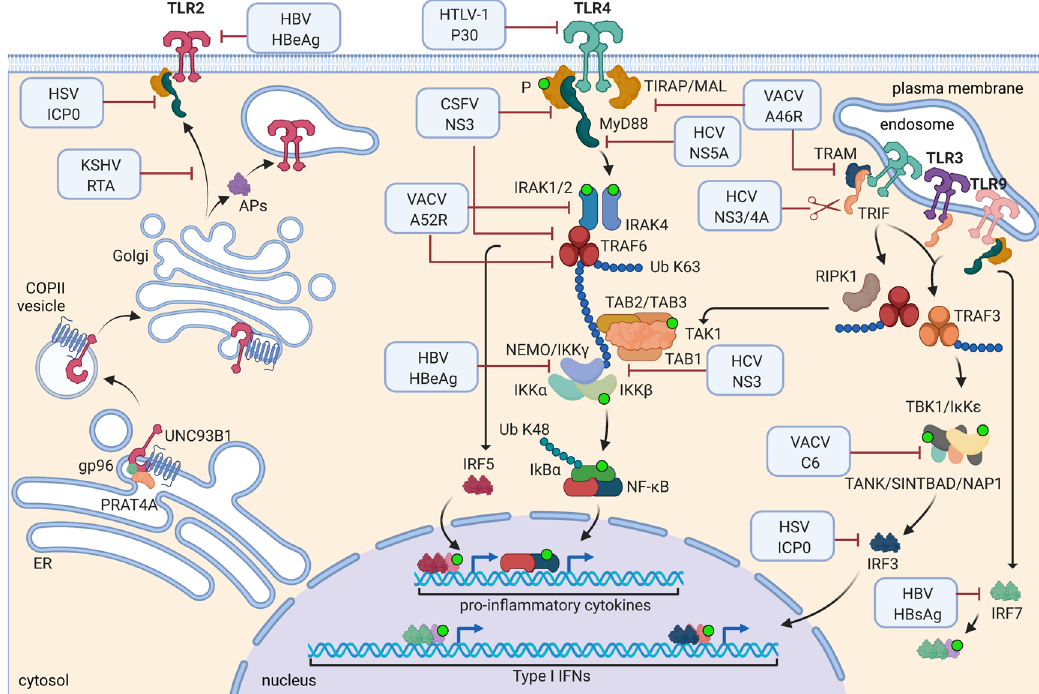
Fig. 3 Mechanisms of viral escape from TLR sensing. Viral proteins can interfere with TLR-mediated pathways through different mechanisms. Some viral proteins, like HTLV-1 protein 30 or HBV HBeAg, directly reduce the expression of TLRs by interacting with their transcriptional factors, while KSHV RTA inhibits TLR2 and/or TLR4 localization at plasma membrane. Other viral proteins possess TIR-like domain that can bind the TIR motifs of the adapter proteins, blocking NF- κ B mediated cytokine production. VACV A46R binds and sequesters MyD88, MAL, TRIF, and TRAM, while A52R interacts with IRAK2 and TRAF6, inhibiting the downstream pathway. TRAF6 can also be targeted by CSFV NSP3. Instead, VACV C6 blocks IRF3- and IRF7-mediated pathways, binding TANK, SINTBAD, and NAP1. HCV exploits its NS3/4A protease to cleave TRIF, while NS5A directly binds to MyD88, blocking its functions. Moreover, HSV ICP0 inhibits IRF3 nuclear accumulation, with subsequent impairment of IFN production. HBV HBsAg inhibits the expression and nuclear localization of IRF7, while HBeAg regulates NF- κ B activity by interacting with NEMO, a strategy employed also by HCV by means of NS3. Created with